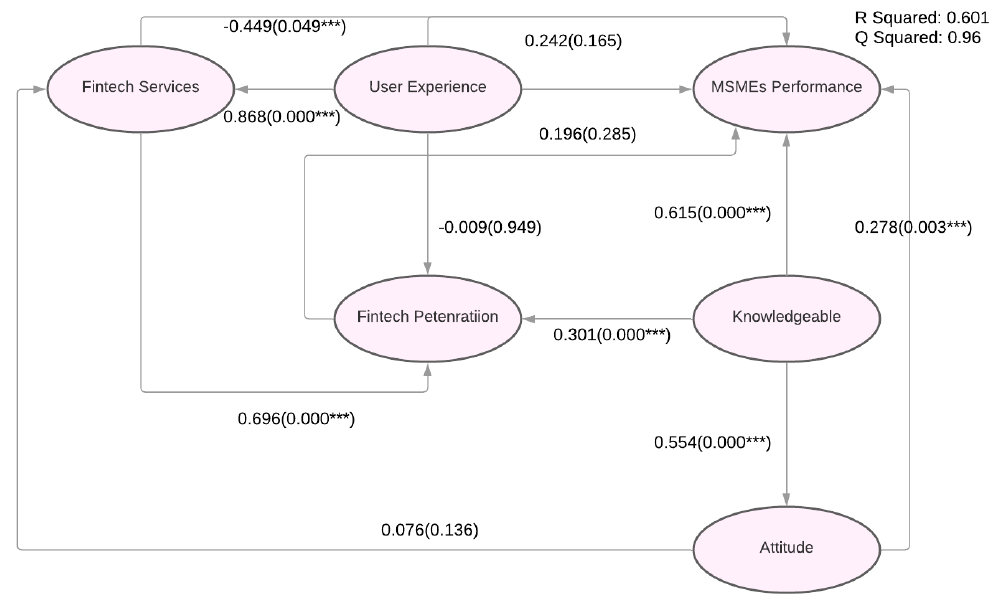
Figure 2. Hypothesis